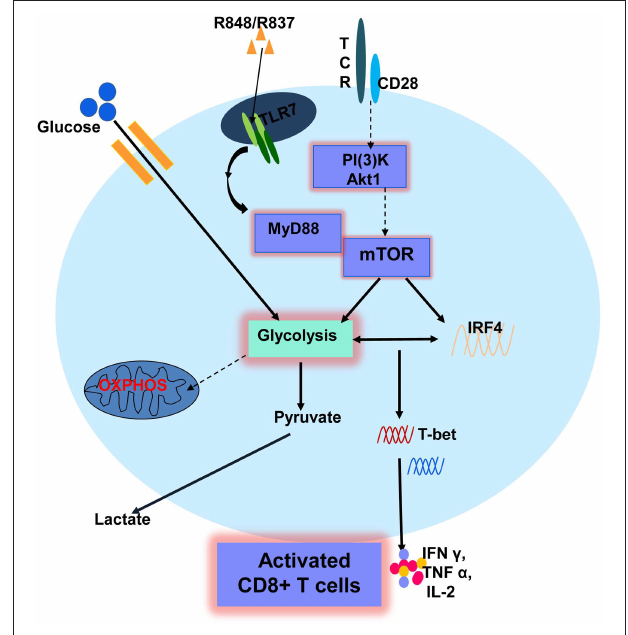
FIGURE 7 | A schematic description of TLR7-mediated enhancement of CD8 + T cell function. TLR7 stimulation promotes the effector functions of CD8 + T cells if CD8 + T cells are primed by α CD3 and express TLR7. TLR7-mediated T cell activation is dependent on MyD88 and AKT-mTOR signaling, leading to the expression of immune-related changes and metabolic alterations in CD8 + T cells, including the upregulation of glucose uptake and glycolysis. Glycolysis was found to be regulated by the AKT-mTOR pathway and a downstream transcription factor IRF4. Glycolysis is critical for TLR7-mediated CD8 + T cell activation and enhanced effector functions of CD8 + T cells. Solid arrows represent signaling pathways identified in this study. Broken arrows indicate potential signaling